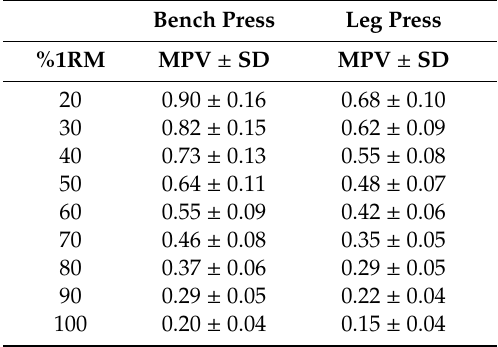
Table 3. T-test of paired samples for the difference between methods.